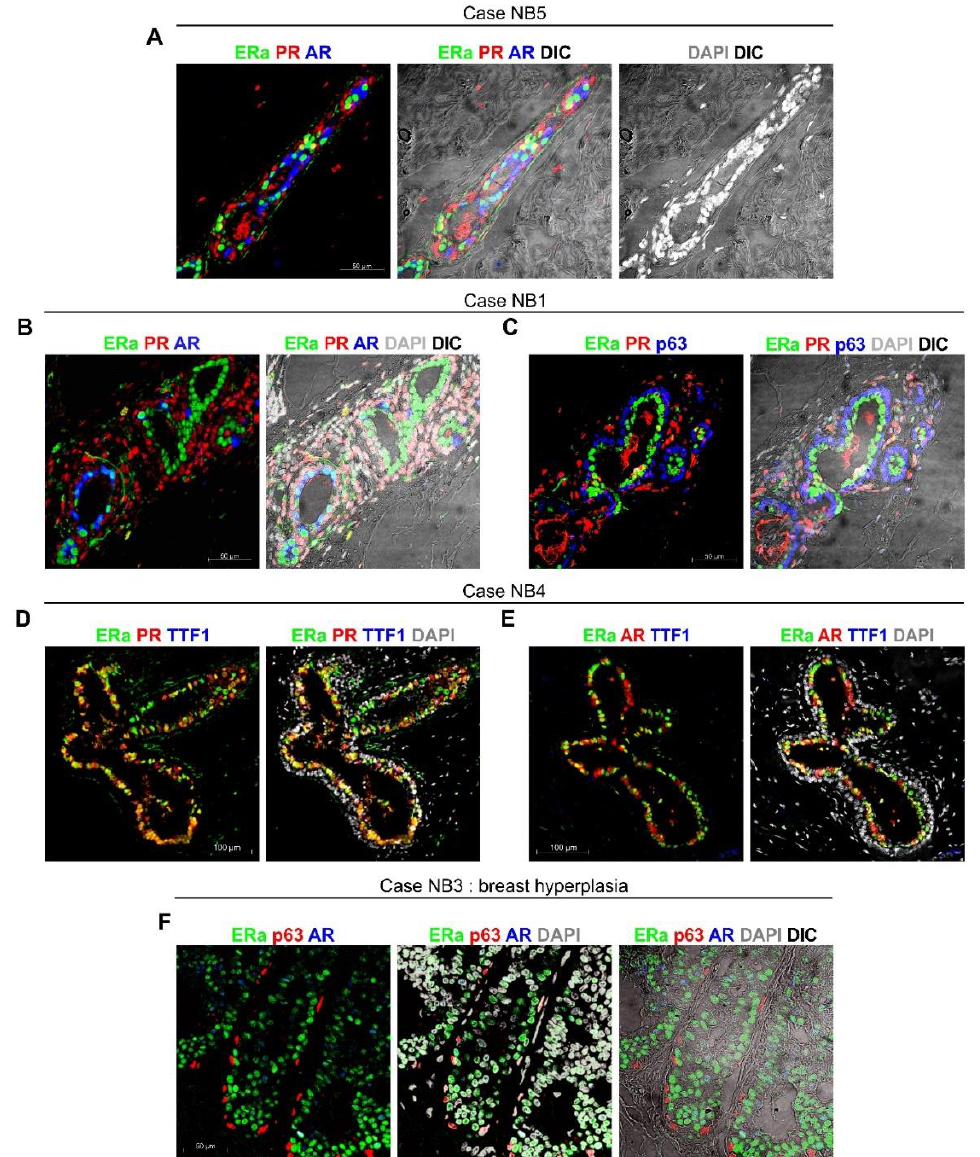
Figure 2. ColNu mIHCF in normal breast tissue from paired cancer cases. ( A ) NB5 reveals some epithelial cells co-expressing ERa + PR; others co-express ERa + AR, while many are single positive for ERa, PR, or AR. Stroma was positive for PR. ( B ) NB1 shows many epithelial cells single positive for ERa, with some colocalizing ERa + AR. PR + cells accumulated in the stroma, suggesting an early alteration. The tissue maintained the basal p63 layer ( C ) showing some positivity for PR. ( D , E ) NB4 also presents many cells co-expressing ERa + PR ( D ) and others co-expressing ERa + AR ( E ), while the basal layer is negative for hormone receptors. TTF1 is negative in the epithelium and inconsistently positive in the stroma. ( F ) NB3 shows hyperplasia of the ERa epithelium with some population co-expressing ERa + AR. The basal p63 layer, negative for hormone receptors, is maintained. The order of antibodies in the consecutive cycles is indicated above each photograph. Pseudocolor was kept constant: green for the 1st, red for the 2nd, and blue for the 3rd cycle. DAPI was included in the mounting medium and reveals the nuclei. DIC is a plane obtained with transillumination for differential interfering contrast-Nomarski and reveals tissue structure.